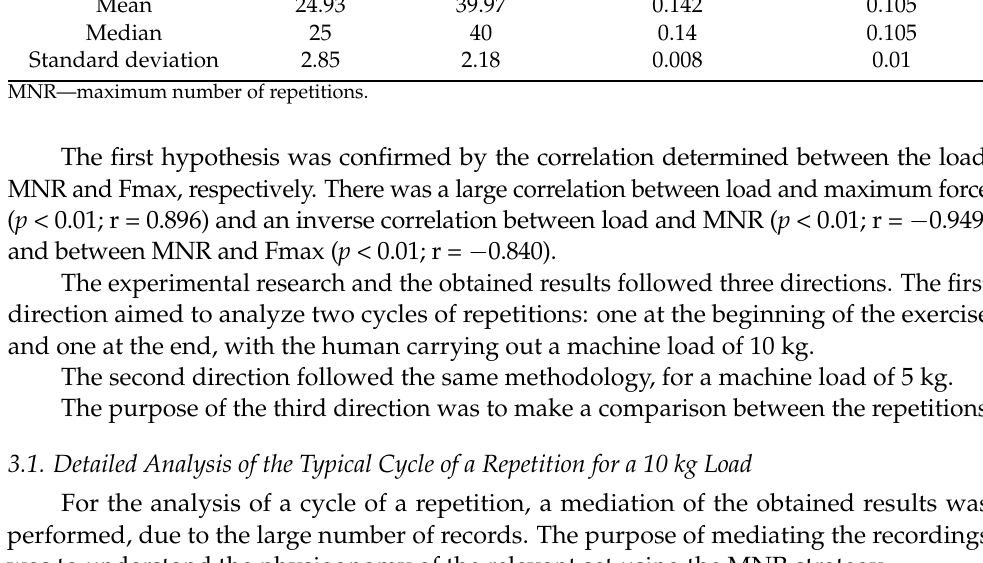
Table 2. Maximum forces per repetition—10 kg load.